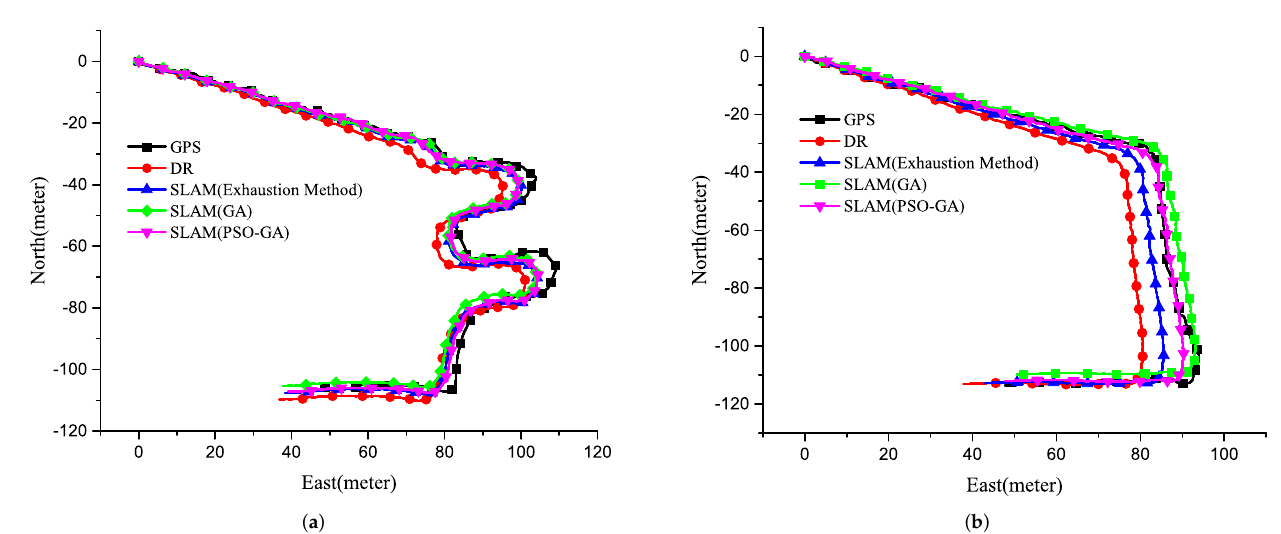
Figure 10. AUV positioning with different navigation methods. ( a ) AUV positioning with different navigation methods in Test 1. ( b ) AUV positioning with different navigation methods in Test 2.